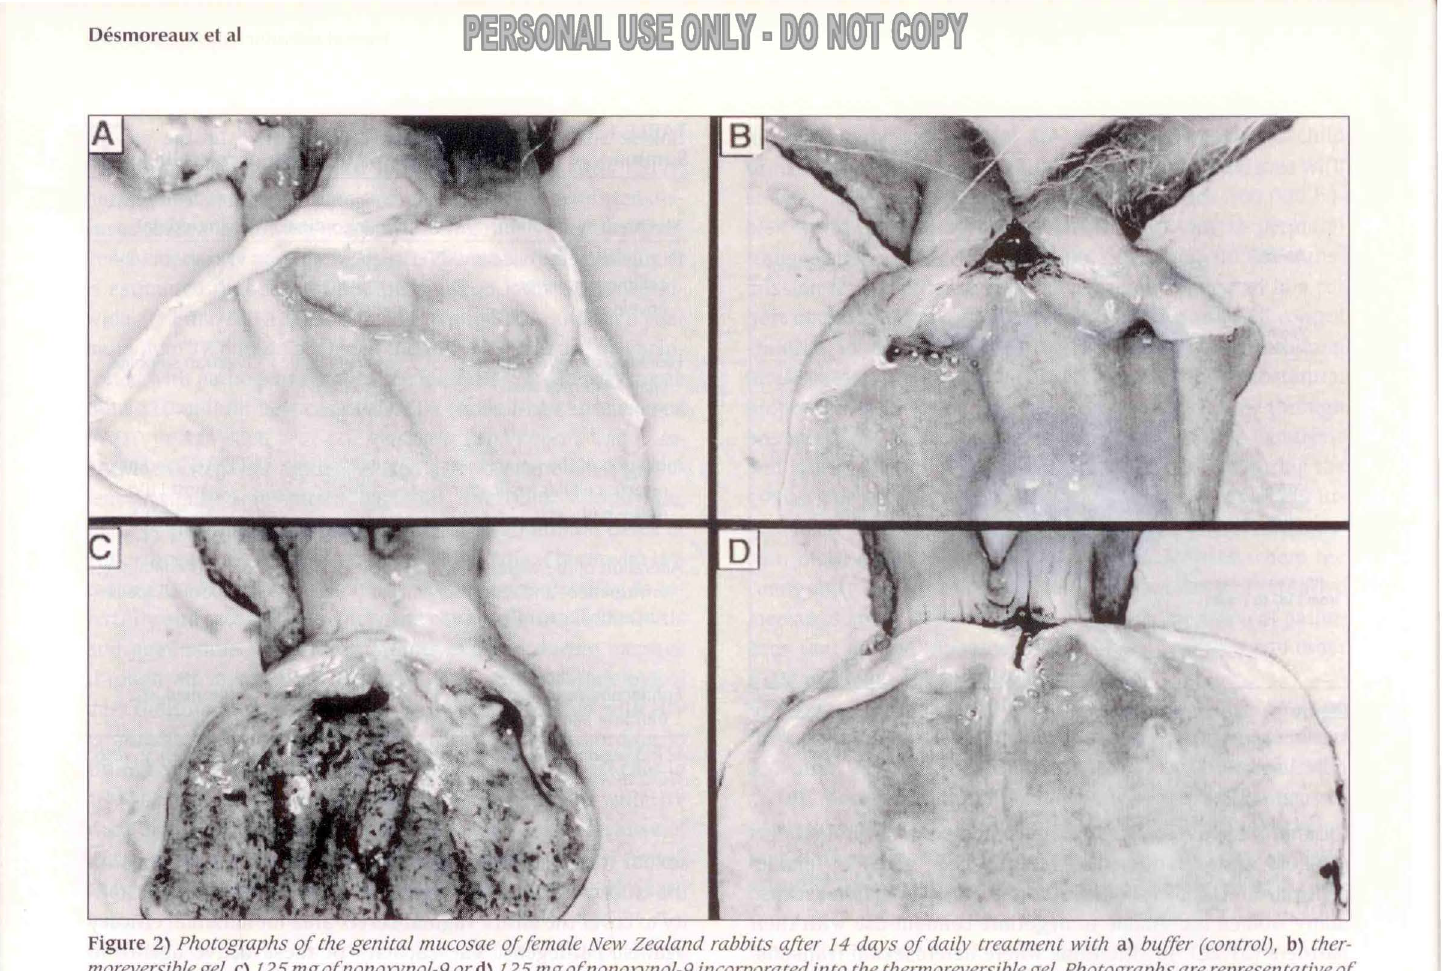
Figure 2) Photographs ef the genital mucosae qf Jemale New Zealand rabbits efter I 4 days ef dai{y treatment with a) bl!ifer (controO, b)